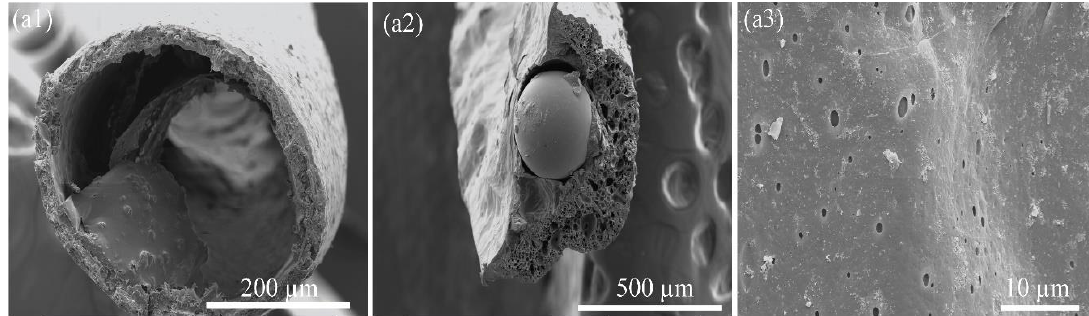
Figure 5. ( a1 ) Core/shell structure from PSp-LM/xylene/PEG that lost PSs, ( a2 ) core/shell structure using PSp-LM/DMF/PEG that retained PSs and ( a3 ) surface morphology.